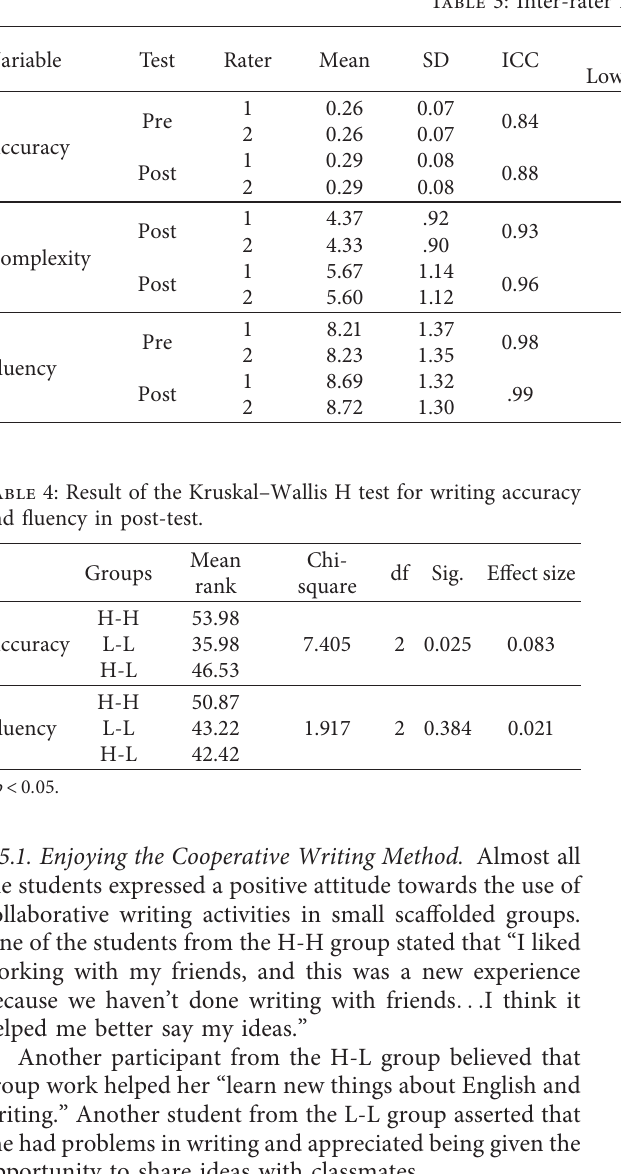
Table 3: Inter-rater reliability results.